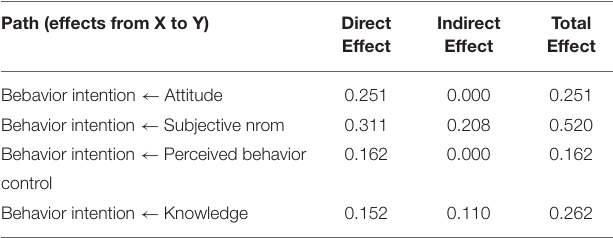
TABLE 5 | Results of direct and indirect